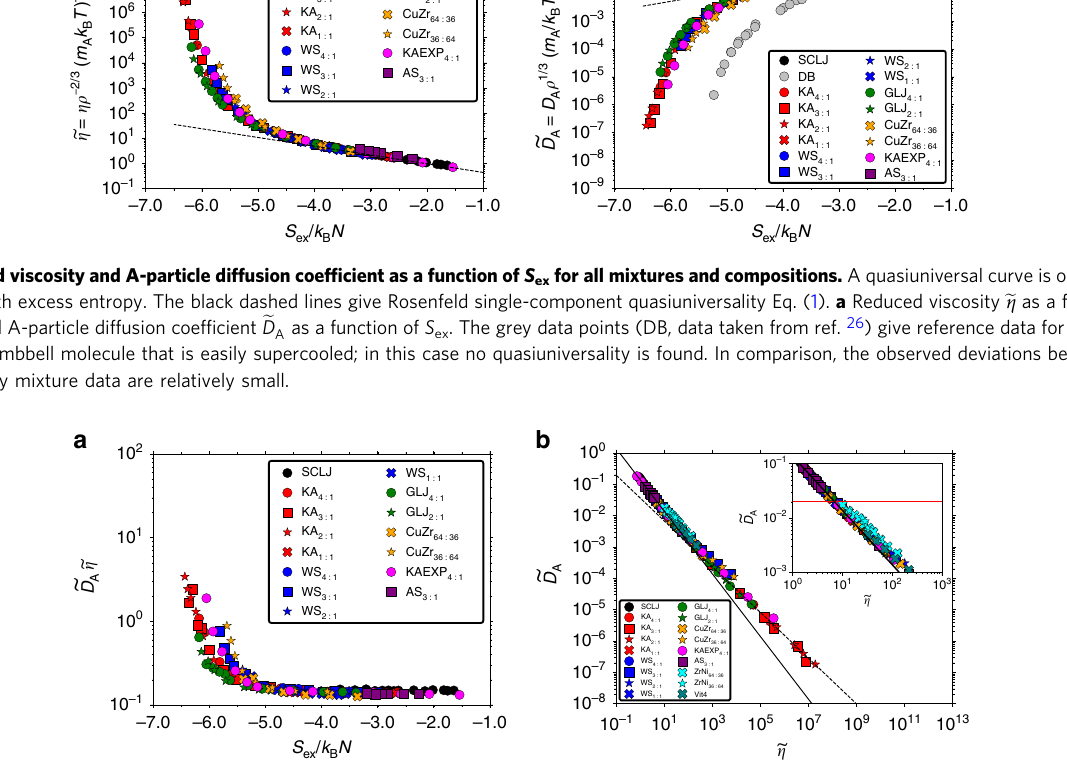
Fig. 4 Breakdown of the reduced-unit SE relation e D A e η = 1/ c π . a The product e D A e η as a function of the excess entropy S ex for all simulated systems. A quasiuniversal breakdown begins around S ex / k B N ≈ − 5.0. b e D A as a function of e η . The full black line is the SE relation with slope − 1 fi tted to 1:1 KA data, and the black dashed line is fractional SE with ξ ≈ 0.73 fi tted to deeply supercooled 2:1 KA data. The aquamarine crosses are experimental data for the binary metallic alloy Zr 64 Ni 36 taken from Brillo et al. 83 and stars are from ref. 85 for Zr 36 Ni 64 ; the diffusion coef fi cient of Ni was measured. The teal-colored data points (ref. 86 ; see also text) are for the Vit4 (Zr 46.8 Ti 8.2 Cu 7.5 Ni 10 Be 27.5 ) fi ve-component metallic glass former probing the diffusion of Ni/Ti/Cu. The inset zooms in on the SE breakdown with the horizontal red line indicating the approximate onset of SE breakdown. A quasiuniversal breakdown is noted around e D (cid:1) 2 × 10 − 2 . A similar conclusion is reached for the B-particles in Supplementary Fig. A